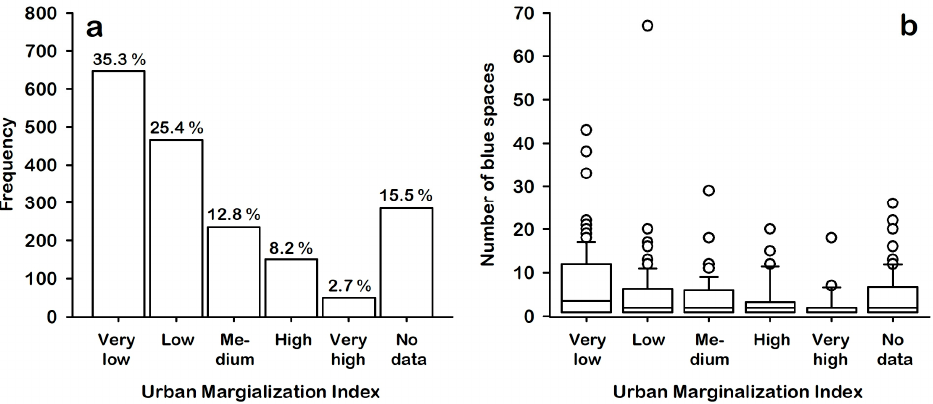
Figure 7. Distribution of the number of lacustrine blue spaces by IMU. ( a ) Bar plot for totals, ( b ) box plot for medians, and interquartile ranks. Table 4. Results from models for the number of blue spaces and the UMI for backward contrasts.